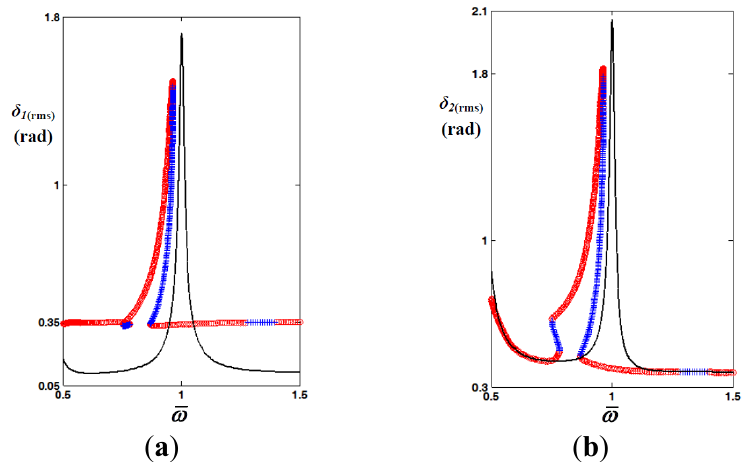
Figure 3. Comparison of root-mean-square (RMS) values of relative displacement between nonlinear and linear analysis: ( a ) RMS values of  